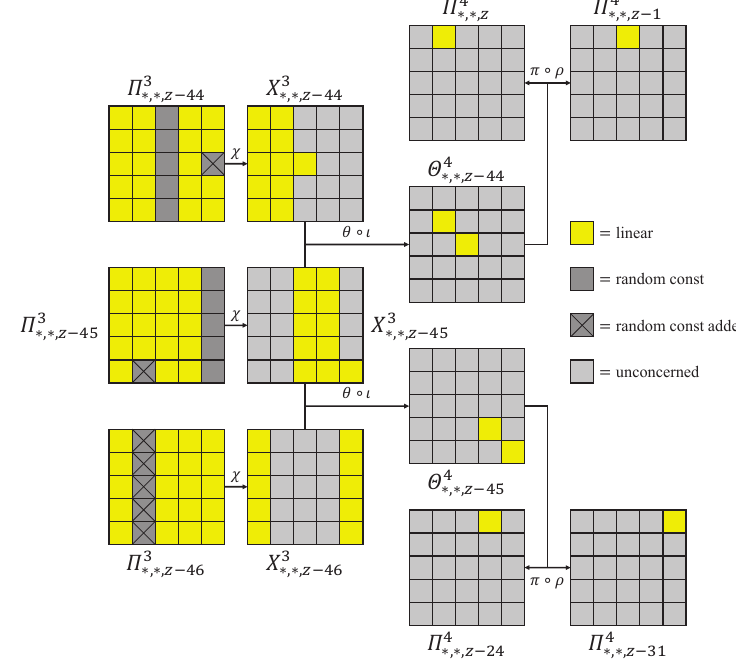
Figure 6: Multiple bits reuse common degrees of freedom.